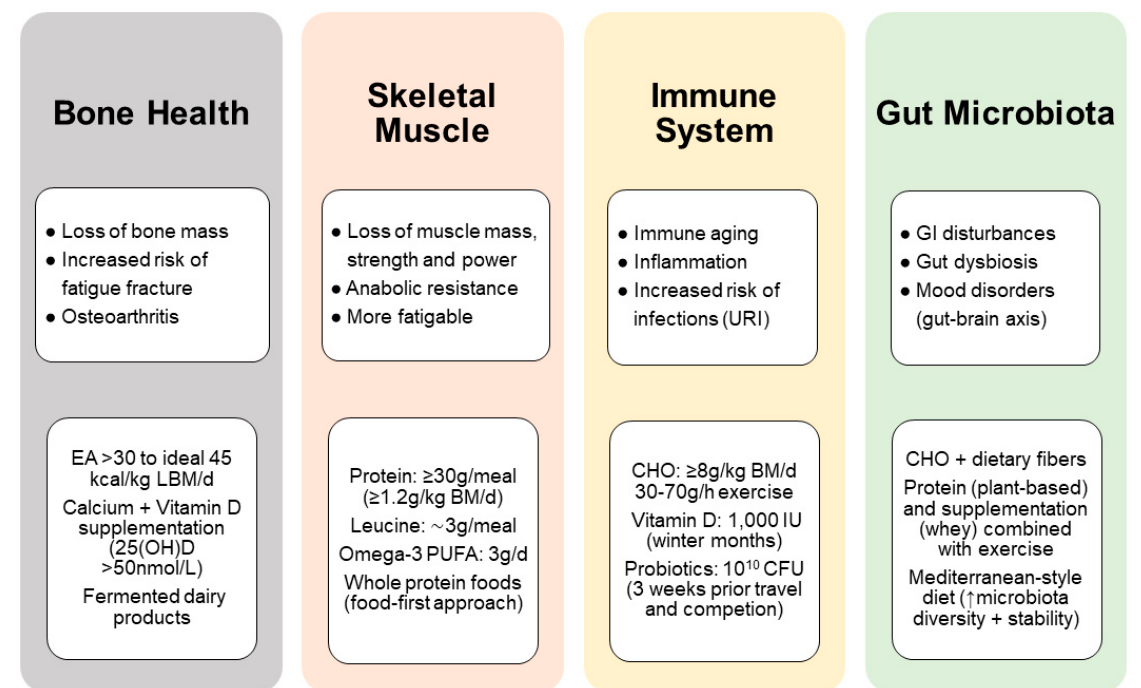
Figure 6. Overview of physiological and diet-related challenges associated with aging and nutritional strategies to assist masters athletes to stay healthy, optimize adaptation and post-exercise recovery. Body mass, BM; colony-forming units, CFU; carbohydrates, CHO; energy availability, EA; gastrointestinal, GI; international units, IU; lean body mass, LBM; polyunsaturated fatty acids, PUFA; upper respiratory illness, URI.